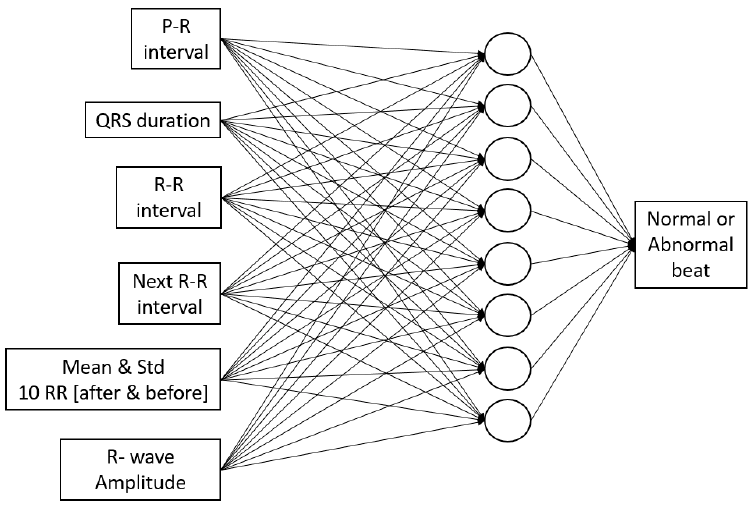
Figure 3. Artificial neural network (ANN) structure for detecting normal or abnormal beat in APC detection algorithm.